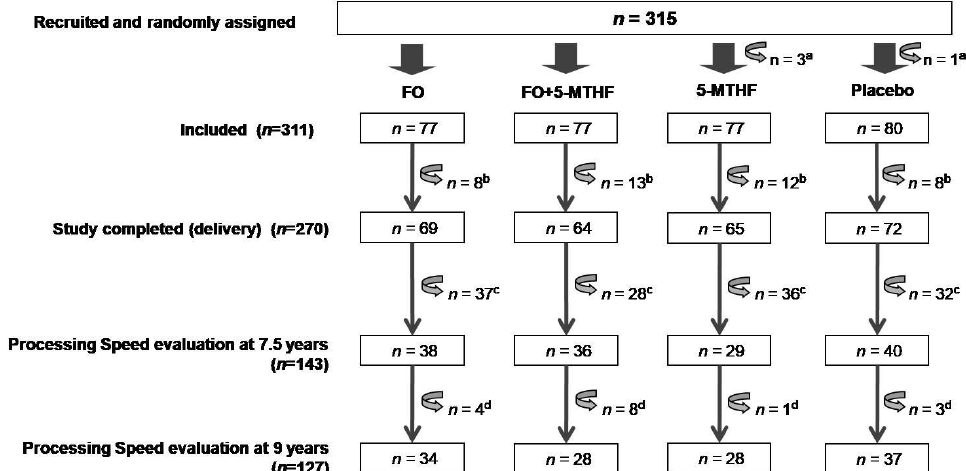
Figure 1. Flowchart of NUHEAL participants up to 9 years. FO: fish-oil; 5-MTHF: 5-methyltetrahydrofolate. a 4 participants who did not meet the inclusion criteria: 2 women weighed > 92 kg, 1 of whom used commercial FO preparations and 2 women regularly consumed FO preparations. b 41 participants did not complete the study: noncompliance ( n = 2), relocation ( n = 1), aversion to or bad taste of the supplement ( n = 9), loss of contact ( n = 2) and unknown reasons ( n = 27). c 133 participants lost to follow up at 7.5 years: relocation ( n = 3), loss of contact ( n = 74), infants born prematurely ( n = 4), congenital left-side anophthalmus ( n = 1), craniosynostosis ( n = 1), left-side deafness ( n = 1), unwillingness to continue ( n = 50). d Processing speed tasks were not entirely performed in 16 participants at 9 years.